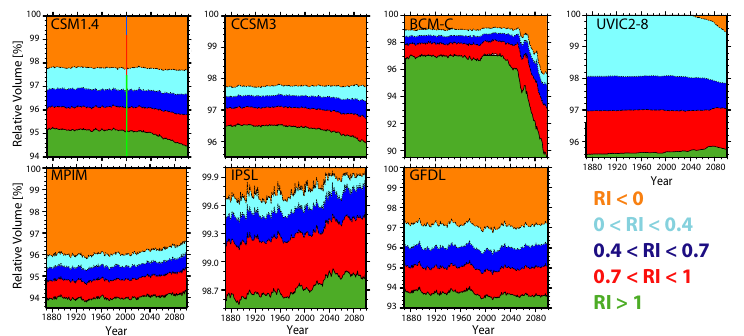
Fig. 14. Projected changes in the volume of waters with a respiration index above (green) and below 1 (red to orange), calculated between 100 and 600m of depth for the SRES A2 scenario. Volumes are given in percent of the oceanic volume in the 100–600m depth range. The observation-based volume is represented in the first panel (vertical bars).